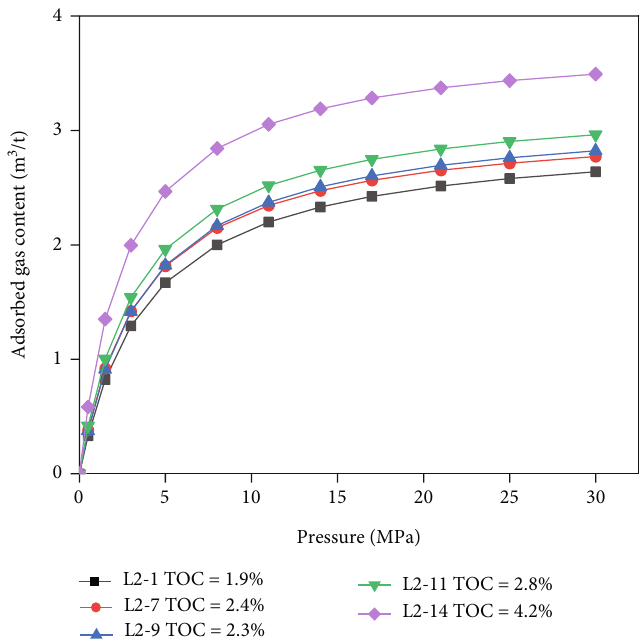
Figure 14: The results from the isothermal adsorption in well L2.